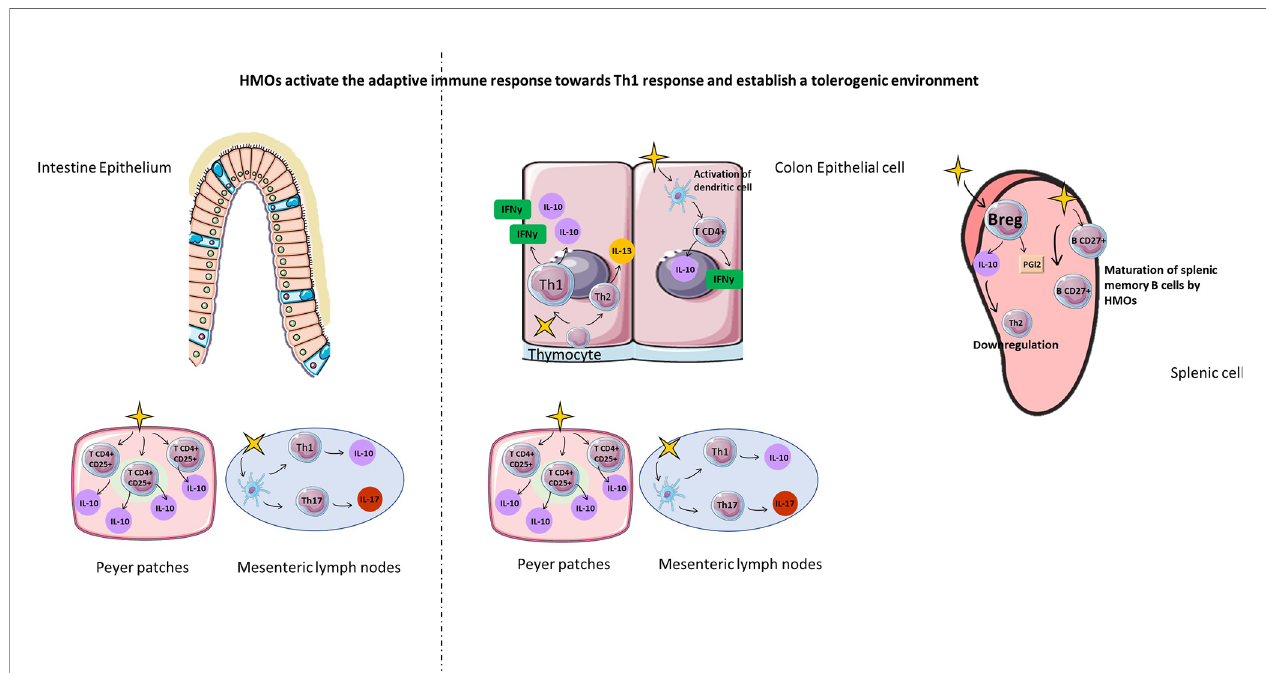
FIGURE 7 | HMOs activate the adaptive immune response towards the Th1 response and establish a tolerogenic environment. HMOs can also act on cellular actors in the adaptative immune (Th1, TH17, TCD4+, Treg, Breg, memory B cells) response in order to fi ght against infectious diseases with a downregulation of Th2 immune response in the intestine and in the spleen. Furthermore, HMOs are able to introduce a tolerogenic environment with stimulation of Treg and Breg